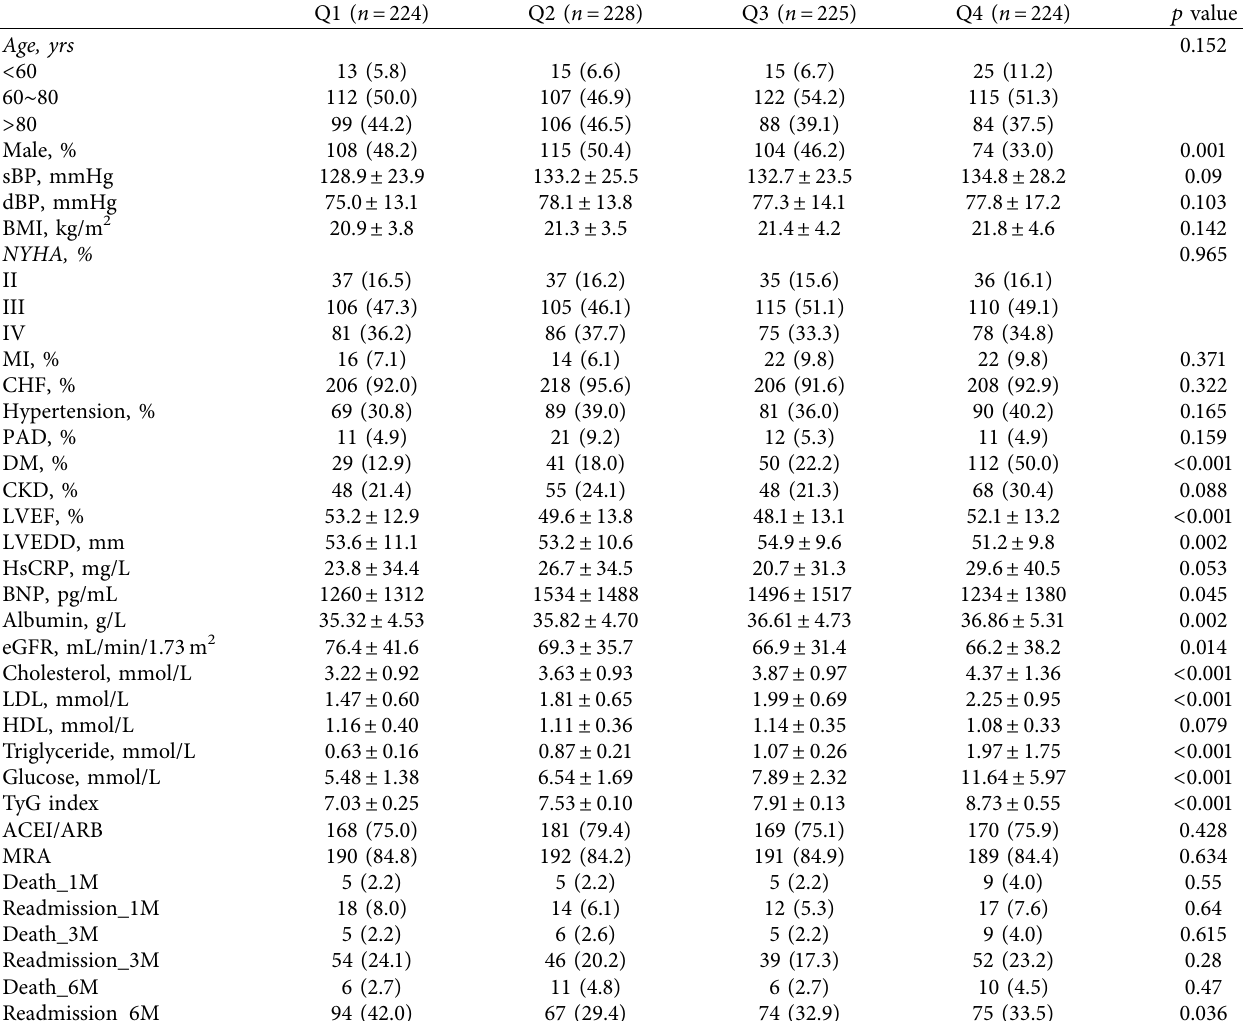
Table 1: The baseline characteristics of HF patients according to the TyG quartile.